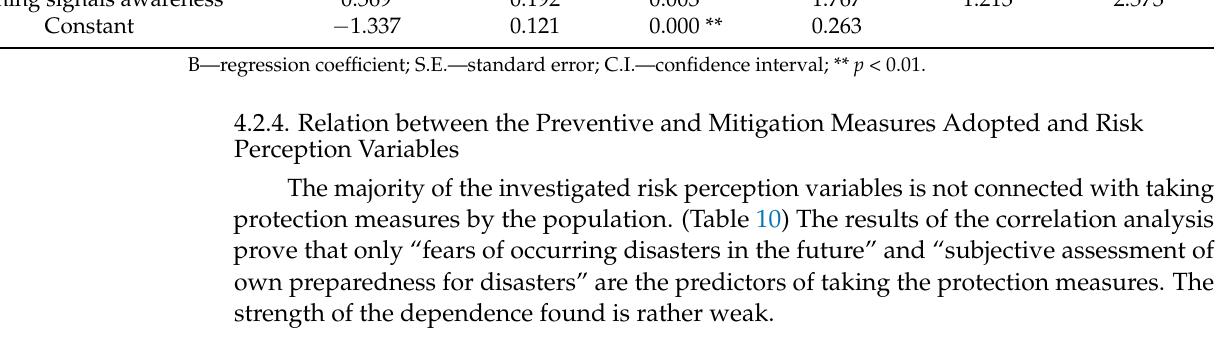
Table 10. Association and correlation between the dependent variable and risk perception variables. Disaster